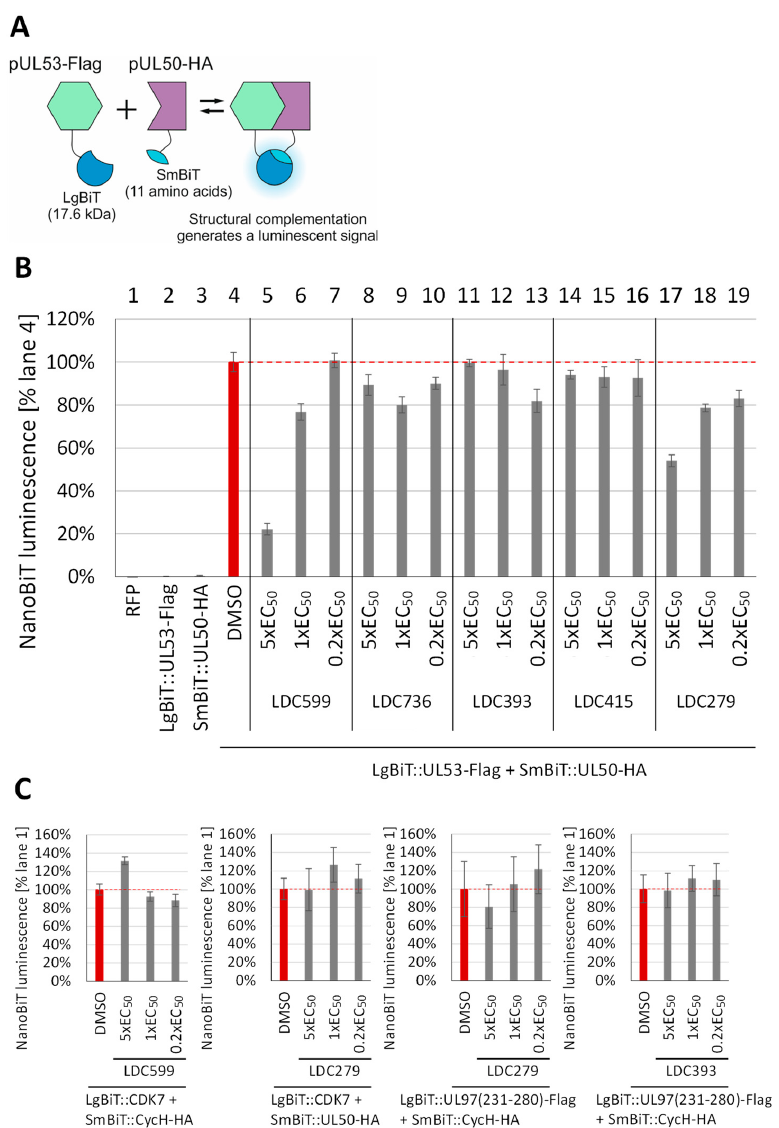
Figure 5. Inhibitory impact of selected LDC warheads on the HCMV core NEC interaction. ( A ) Schematic illustration of the cloned fusion constructs expressing one part (LgBiT or SmBiT) of the split luciferase